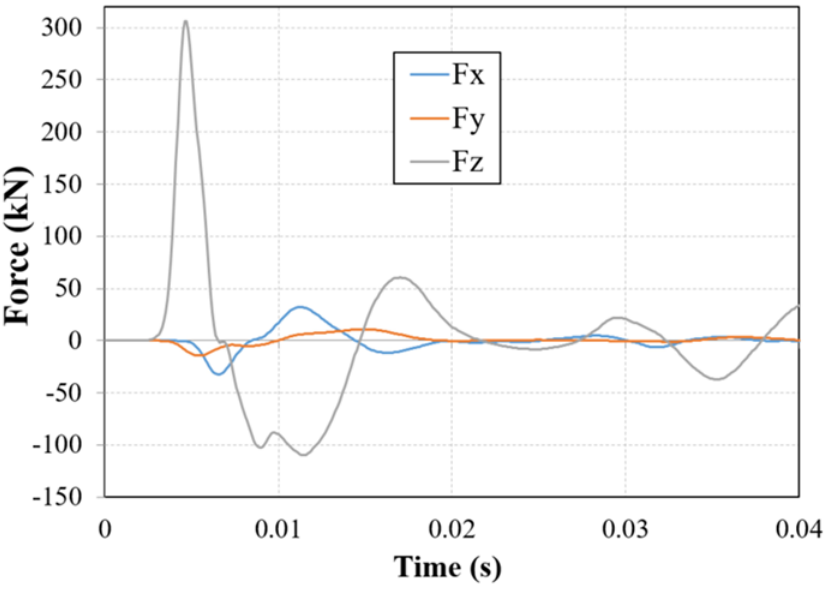
Figure 4. Components of the force acting on the obstacle at a distance of 2.5 m depending on time.